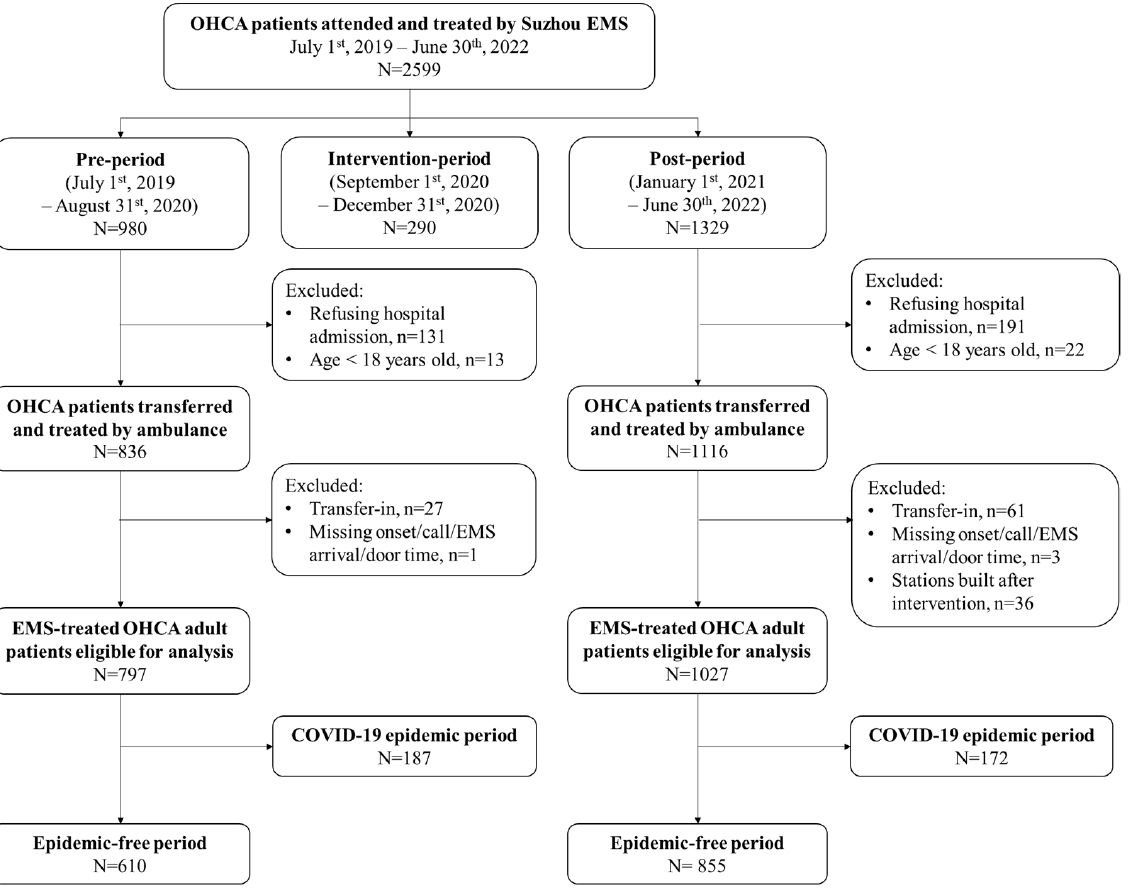
Figure 2. Patient flowchart. OHCA, out-of-hospital cardiac arrest; EMS, emergency medical ser- vices. There were 2 COVID-19 epidemic periods in Suzhou: 1 February 2020 to 30 April 2020 of pre- period, and 1 February 2022 to 30 April 2022 of post-period, respectively.